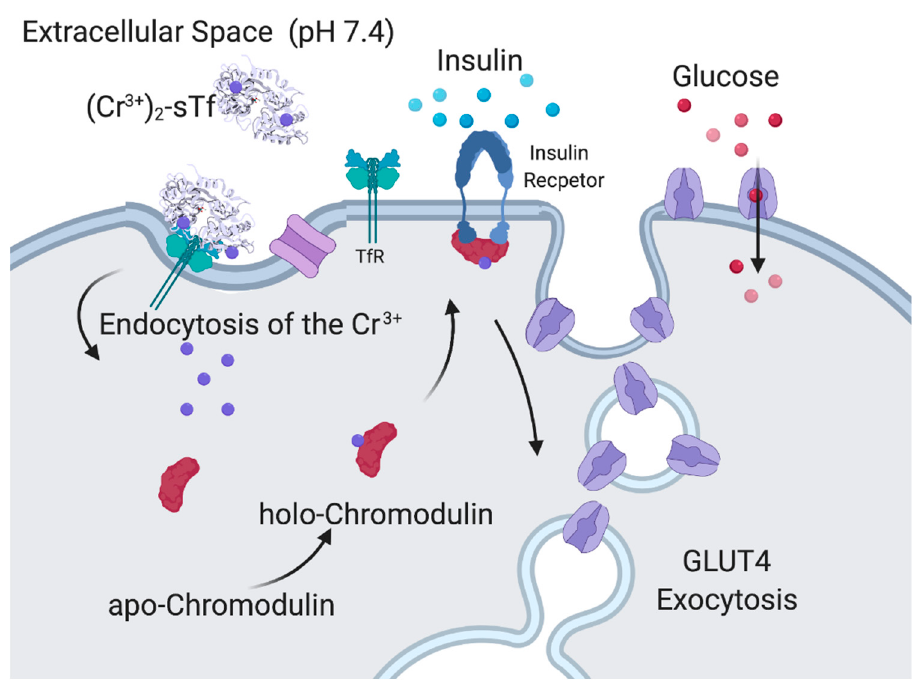
Figure 16. Proposed insulin-enhancing mechanism of Cr(III) facilitated by its chromodulin interaction. Created with BioRender.com.